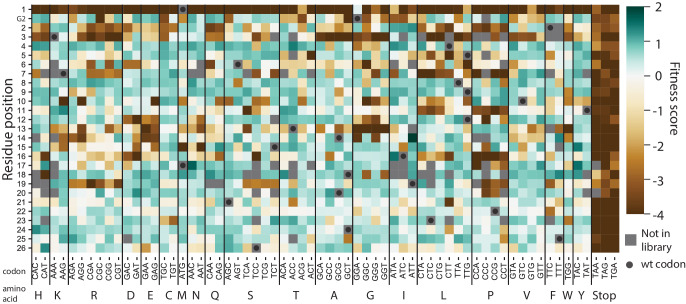
Heat map of codon variant fitness scores for the signal peptide of VIM-2 under selection in 128 µg/mL AMP.The residue positions are indicated on the y-axis (G2 refers to the Glycine two in the inhouse sequence that is not a part of wtVIM-2), while the codon mutations are indicated on the x-axis.